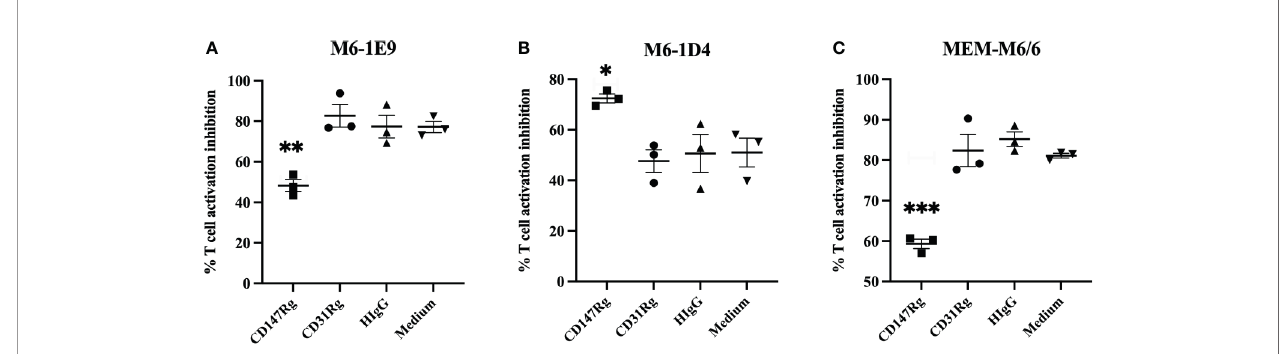
FIGURE 2 | Abolishing of the inhibitory effect of anti-CD147 mAbs through the recombinant CD147 extracellular domain. CFSE-labeled PBMCs ( n = 3) were stimulated with an anti-CD3 mAb in the presence or absence of an anti-CD147 mAb, (A) M6-1E9, (B) M6-1D4 or (C) MEM-M6/6, mixture with recombinant CD147 proteins as indicated. After 5 days of culture, cell proliferation was determined by fl ow cytometry. The % proliferation inhibition in the indicated conditions was calculated by normalizing relative to the condition lacking anti-CD147 mAb. The graphs represent the mean ± SE, and two-way ANOVA followed by Tukey ’ s test was used for comparison. * represents p ≤ 0.05, ** p ≤ 0.01 and ***p <